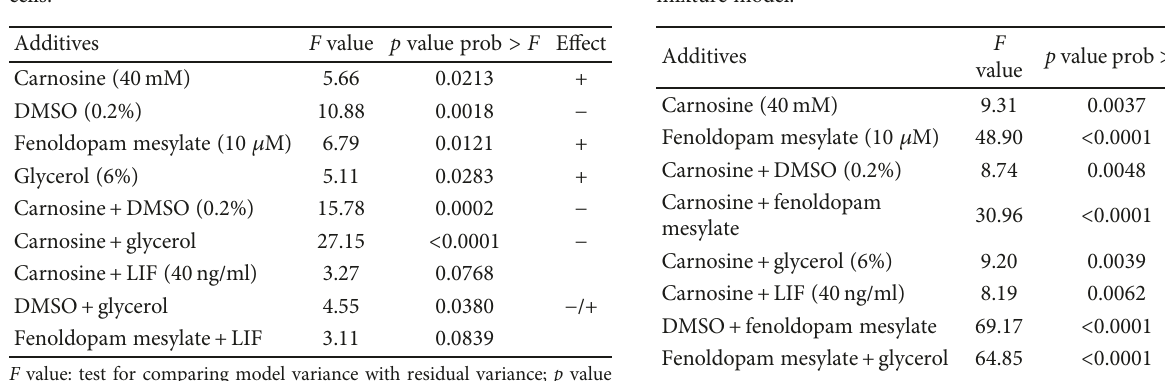
Table 4: Reduced quadratic mixture model for the number of live cells.